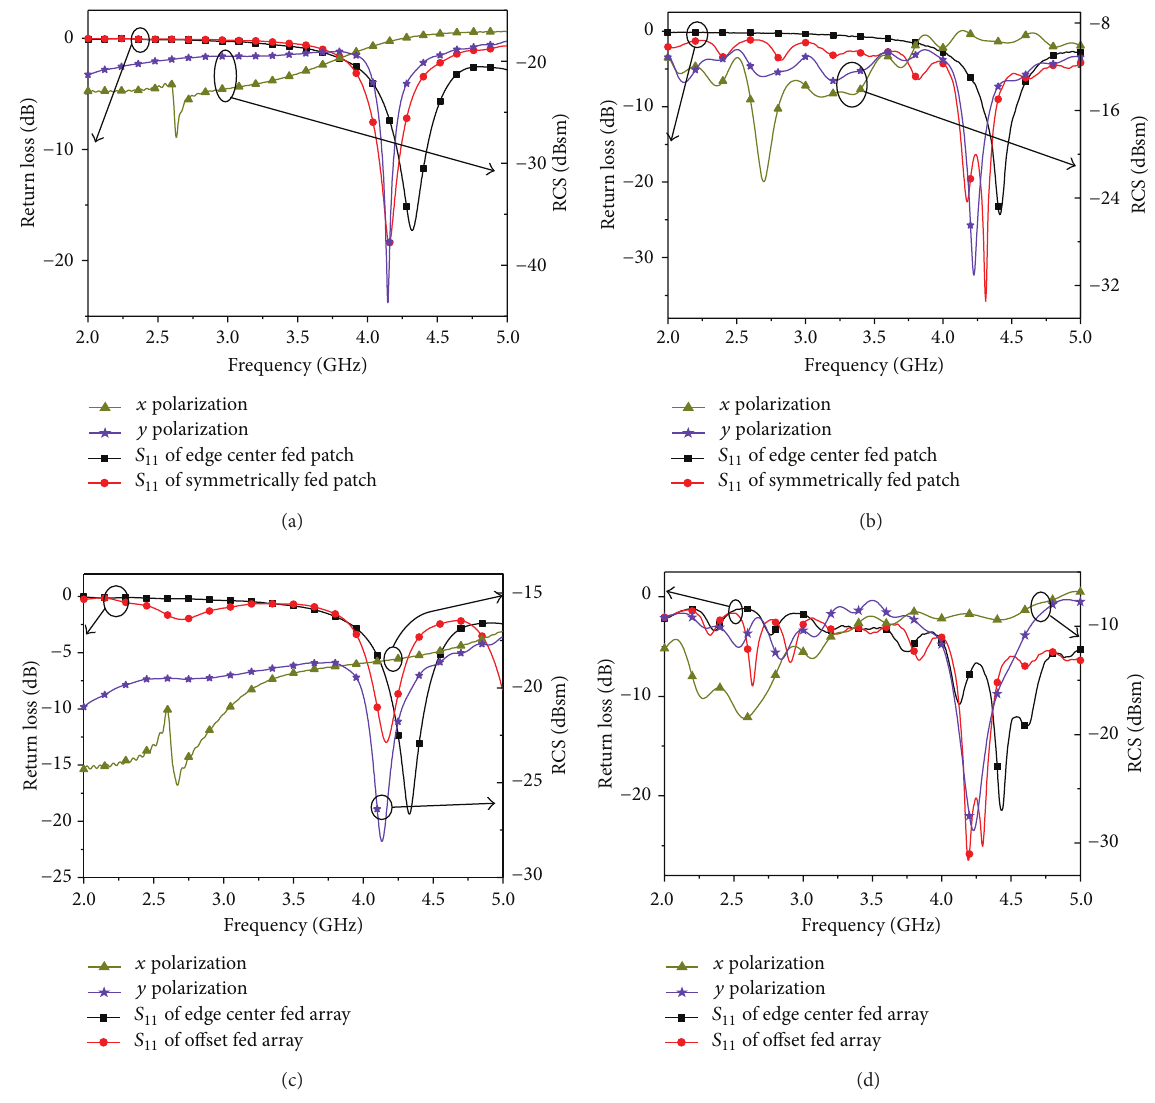
Figure 11: Comparison of monostatic RCS and 𝑆 11 of the two antennas from Figure 7, with 𝑥 - and 𝑦 -polarized plane waves incident to the normal direction: (a) simulated and (b) measured results of the symmetry offset fed patch antenna and (c) simulated and (d) measured results of the offset fed patch